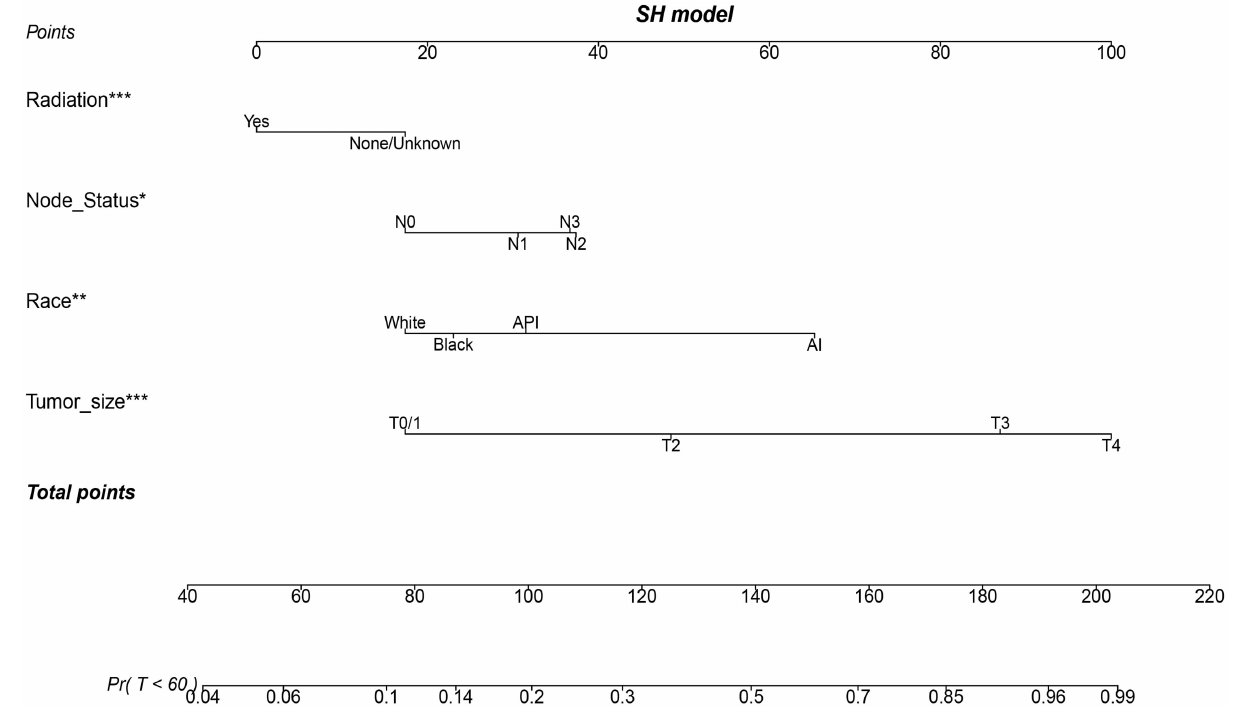
Frontiers in Oncology |